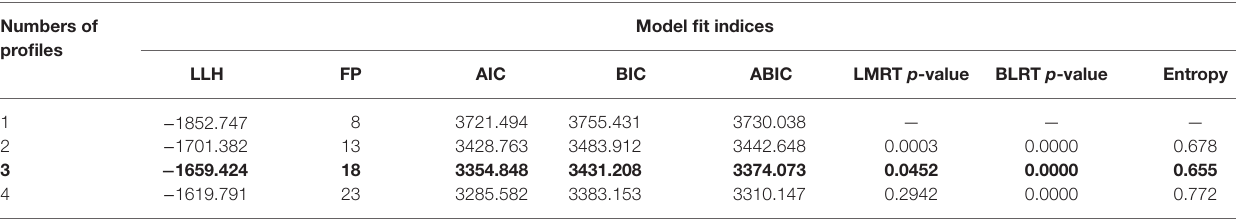
TABLE 3 | Model fit indices.